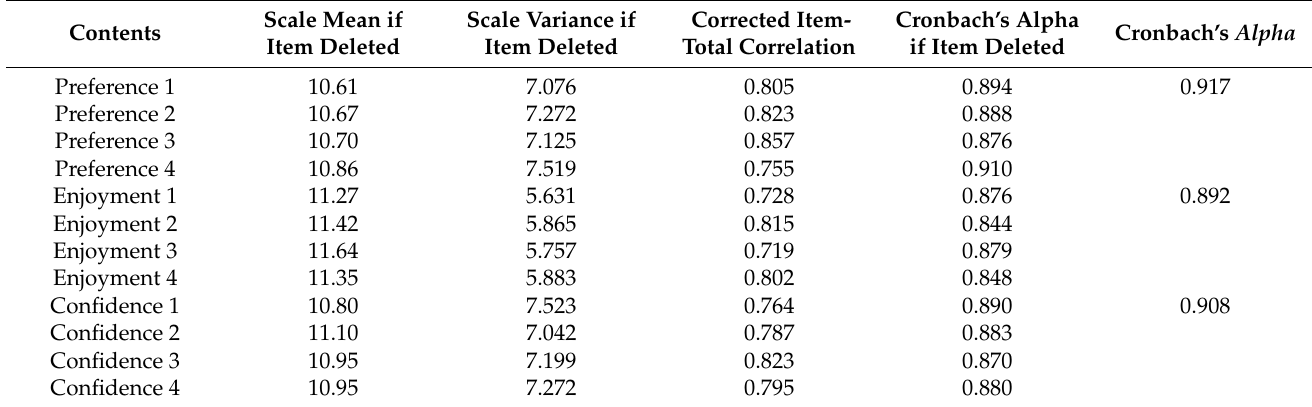
Table 5. Cronbach’s a analysis results of physical activity attitude.